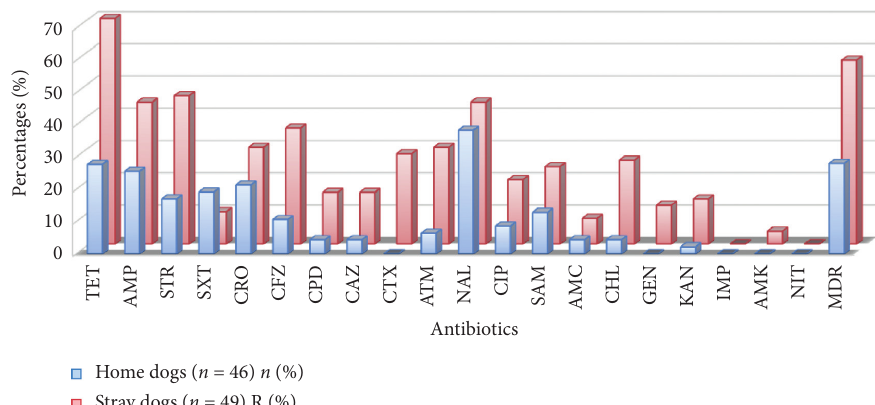
Figure 1: Antimicrobial resistance percentages in home dog and stray dog strains. TET (tetracycline), AMP (ampicillin), STR (strep- tomycin), STX (sulfamethoxazole-trimethoprim), CRO (ceftriaxone), CFZ (cefazolin), CPD (cefpodoxime), CAZ (ceftazidime), CTX (cefotaxime), ATM (aztreonam), NAL (nalidixic acid), CIP (ciprofloxacin), SAM (ampicillin-sulbactam), AMC (amoxicillin-clavulanic acid), CHL (chloramphenicol), GEN (gentamicin), KAN (kanamycin), IMP (imipenem), AMK (amikacin), NIT (nitofuratoin), MDR (multidrug-resistant). Table 1: Prevalence of antimicrobial resistance E. coli isolated from pets and stray dogs. Antimicrobial-resistant E. coli isolated from Antimicrobial agents Home dogs ( n �